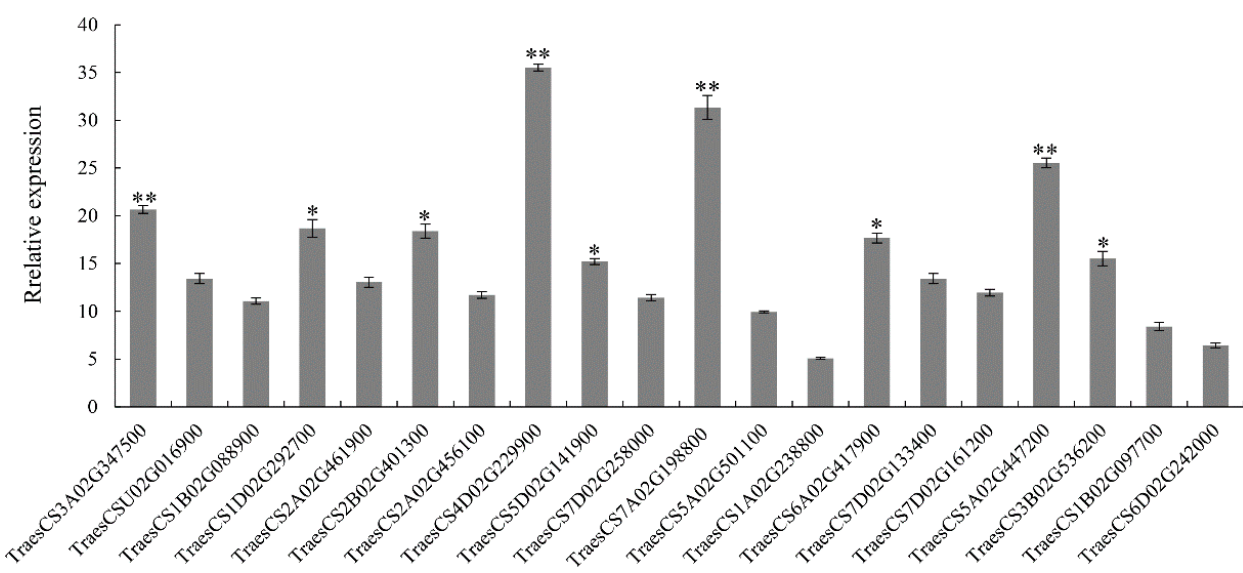
Figure 2. Relative expression analysis of 20 candidate marker genes in the leaves of wheat cultivar CN19 treated with chitin for 4 h. The relative expression of 20 candidate marker genes were examined by qRT-PCR, and the expression levels of these genes were calculated by using the comparative threshold (2 − ∆∆ CT ) method, and values are expressed relative to an endogenous wheat reference gene TaActin . Bars represent standard deviations (SD), which were calculated from 3 independent biological replicates ( n = 3). Asterisks indicate significant differences calculated using Student’s t -test. (* p < 0.05, ** p < 0.01).